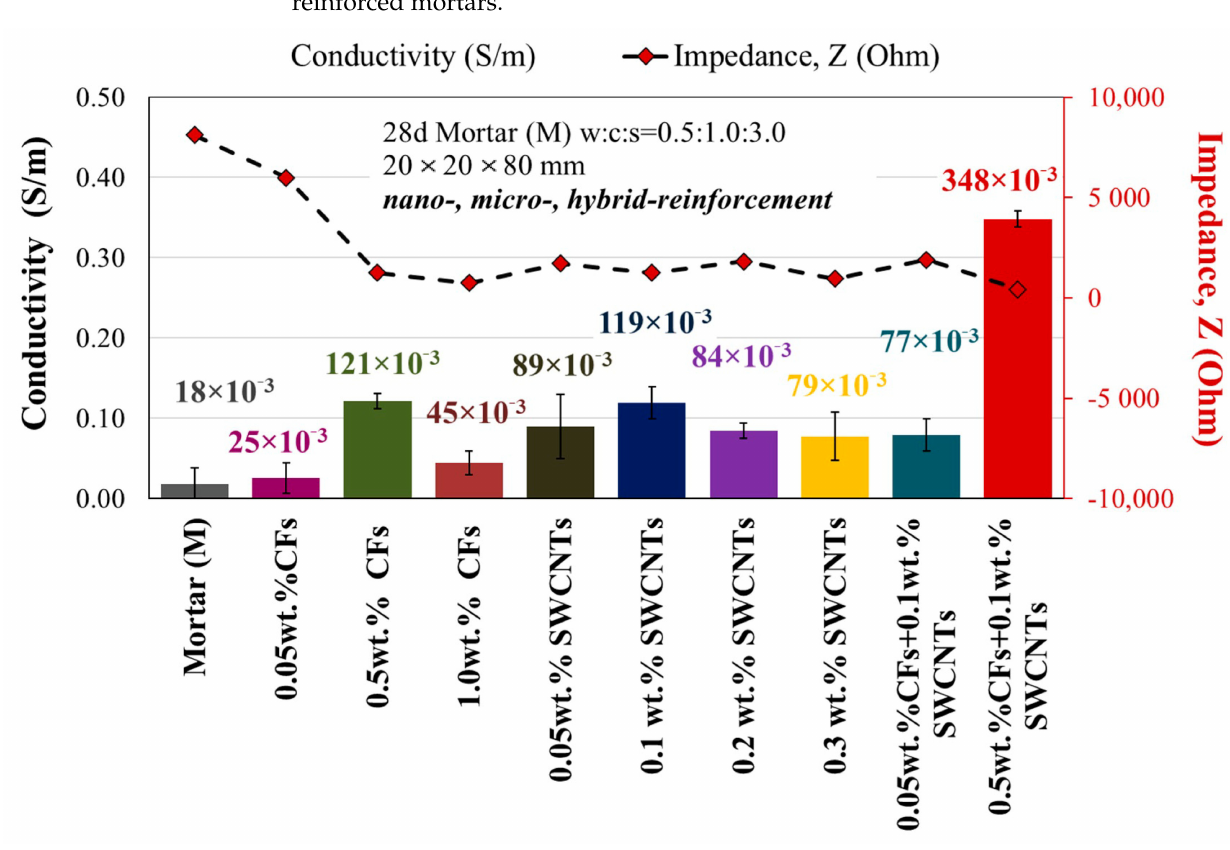
Figure 5. Average conductivity of 28 d plain reference and modified mortars with different concen- trations (wt.%) of SWCNTs and CFs, or hybrid combination at 28 days.